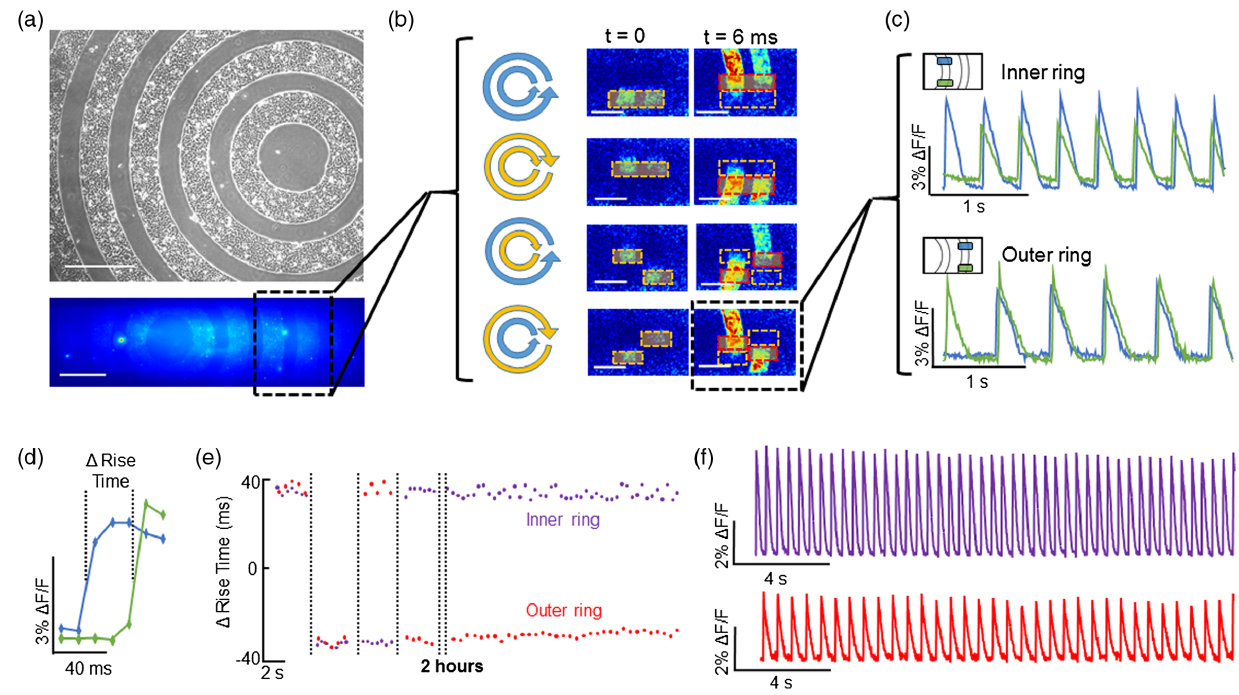
FIG. 2. Ring oscillators in annular OS-HEK cell cultures. (a) Top: Transmitted light image of micropatterned rings of OS-HEK cells. Bottom: The fluorescence field of view is limited to a slice through the rings. (b) Optical initiation of directional waves in the annular cultures. In two concentric rings, waves are launched sequentially in all four binary combinations of directions. Dashed boxes indicate the illumination sequences used to launch the waves. Scale bars in (a) and (b), 1 mm. (c) Intensity patterns of QuasAr2 fluorescence after wave initiation. (d) A slight time shift in the upstroke of the waves measured at different locations on the annulus indicate the direction of circulation. (e) Writing of all four two-bit binary patterns. Red and purple dots indicate the direction of propagation in the outer and inner rings, respectively. The last pattern is left undisturbed at room temperature and continues to circulate for > 2 h. (f) Oscillation patterns in regions of the inner and outer rings after 2 h of continuous circulation, corresponding to ∼ 10 4 cycles. See Movie 3 in Supplemental Material